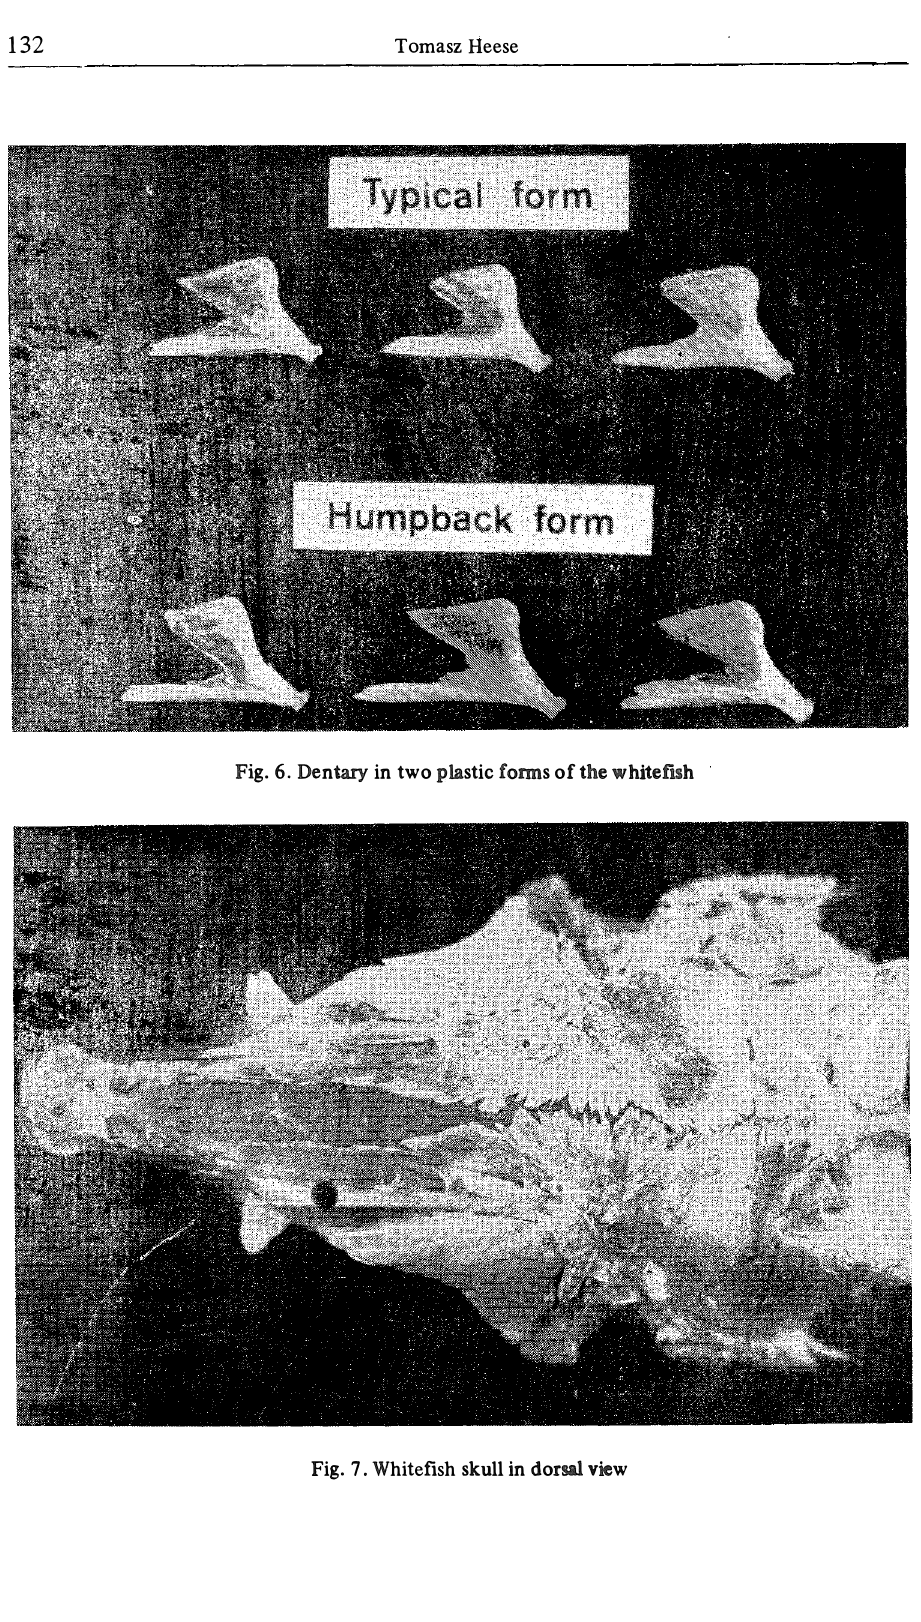
Fig. 7. Whitefish skull in dorsal